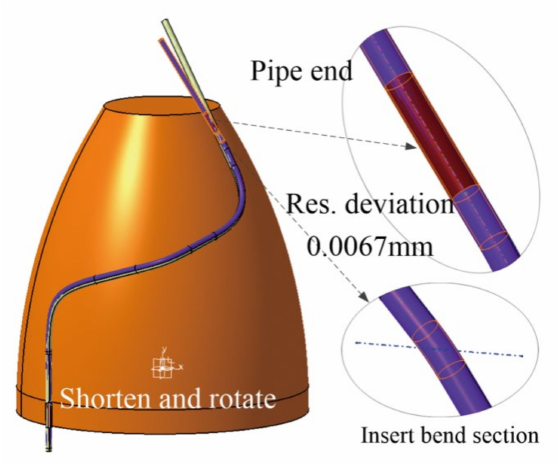
Figure 12. Virtual assembly after using the calculation parameters from No.